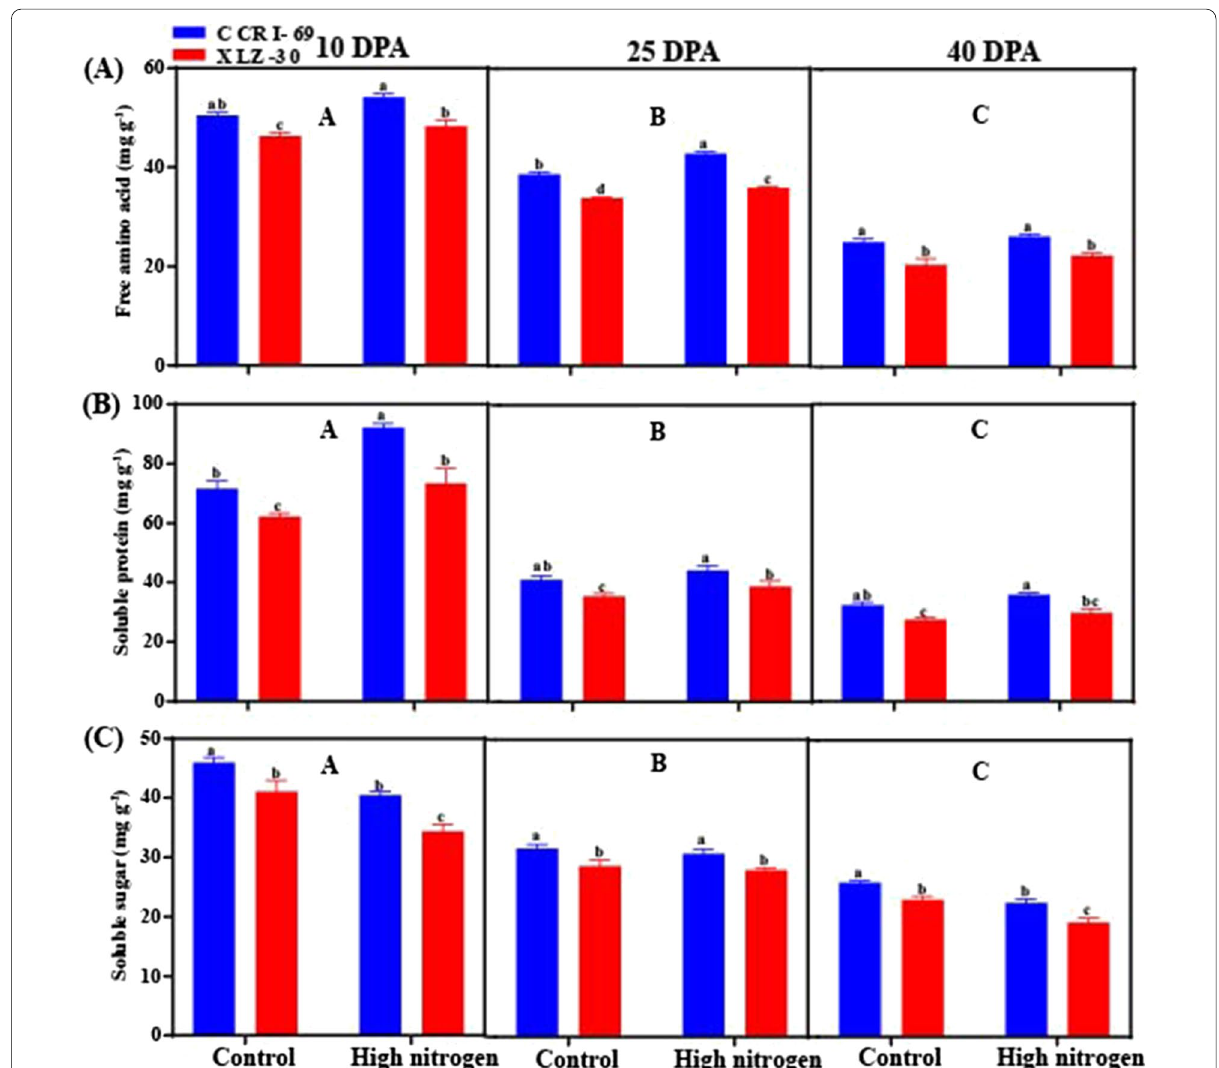
Fig. 3 A Free amino acid (mg g − 1 ), B soluble protein (mg g − 1 ), and C soluble sugar (mg g − 1 ) in cotton subtending leaves of CCRI-69 and XLZ-30 · · · under control (2.5 mmol L − 1 ), and high (5 mmol L − 1 ) N conditions at 10, 25, and 40 days post-anthesis (DPA). Error bars with different lower case · · letters show a significant difference between genotypes under control and high N condition and capital letters in the brackets show significant difference among growth stages (10, 25, and 40 DPA) at P <